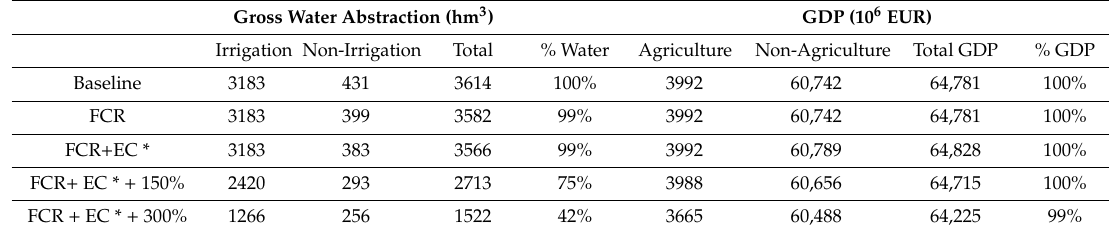
Table 4. Estimated water withdrawal vs. scenarios of water pricing. Guadalquivir 2012.